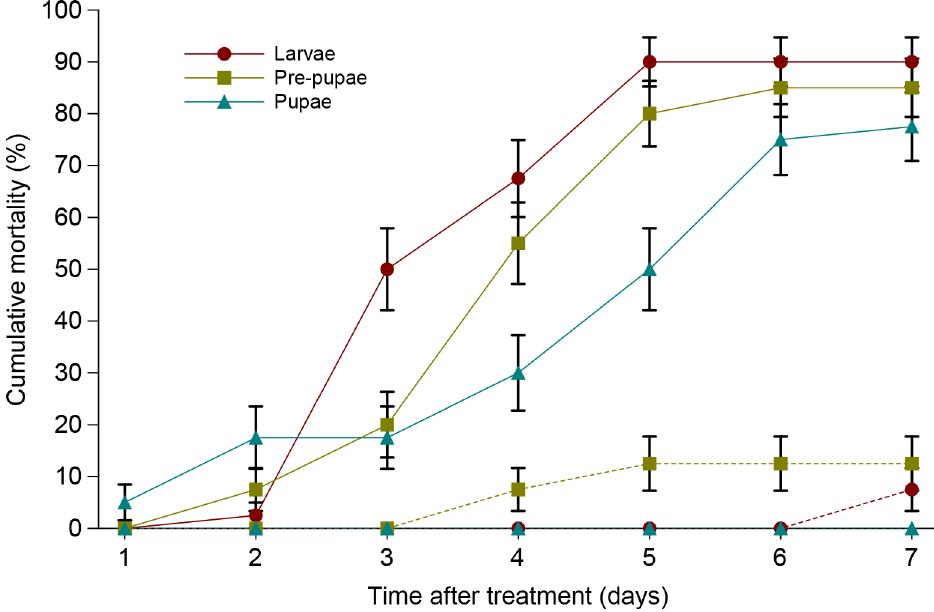
Fig 1. Cumulative mortality of last-instar larvae, pre-pupae and pupae of L . decemlineata treated by I . fumosorosea CCM 8367. Dashed lines indicate mortality in controls. Vertical bars indicate standard